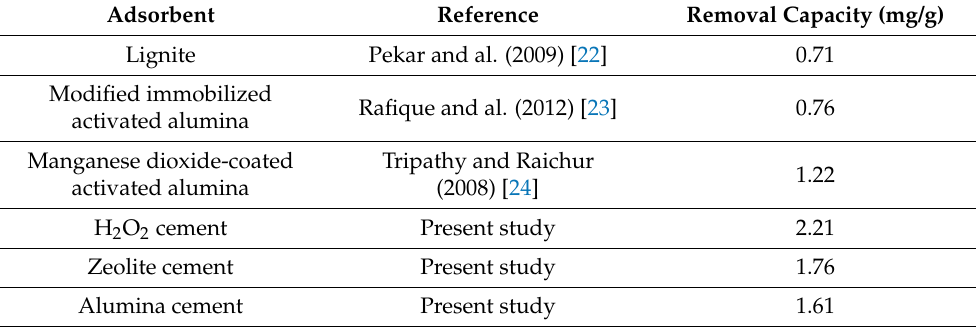
Table 3. Comparative fluoride removal capacity of some